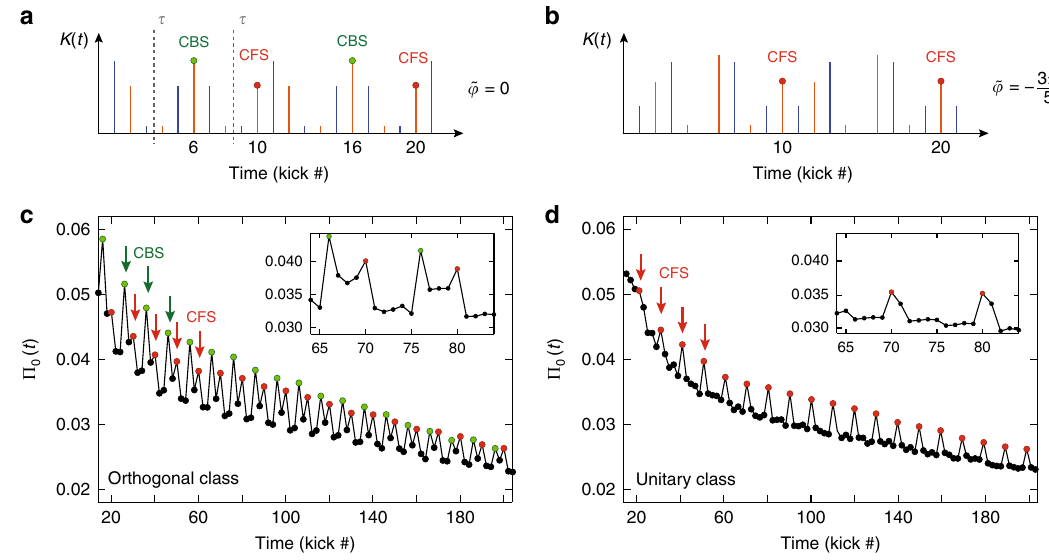
Fig. 2 Experimental observation of CBS and CFS peaks in two symmetry classes. Using two periodically modulated kick sequences with different symmetry properties, we measure the time-evolution of the zero-momentum probability density Π 0 ( t ). a The kick sequence with ~ φ ¼ 0 in Eq. (5) has symmetric amplitudes Kð t Þ and antisymmetric phases a ( t ) by reversing time around τ = 3.5 (and 8.5) kicks, so that the system is in the orthogonal symmetry class. b For ~ φ ¼ (cid:2) 3 π = 5, the sequence has no symmetry, putting the system in the unitary class. c In the orthogonal class, we observe two distinct enhancements of Π 0 ( t ), at times t = 6 (mod. 10) and t = 0 (mod. 10), associated to CBS (green) and CFS (red) peaks, respectively. The CBS peaks have maximum contrast early during the kick sequence, and decrease due to stray decoherence, whereas the CFS peaks start by slowly increasing in contrast, and equalize the CBS at longer times. This constitutes a genuine interferential signature of the emergence of Anderson localization. d The time evolution of Π 0 obtained with a Hamiltonian with broken PT -symmetry clearly shows the disappearance of the CBS peaks in the unitary class. The CFS peaks, insensitive to the symmetry breaking, continue to be present, with a contrast following the same increasing trend at short